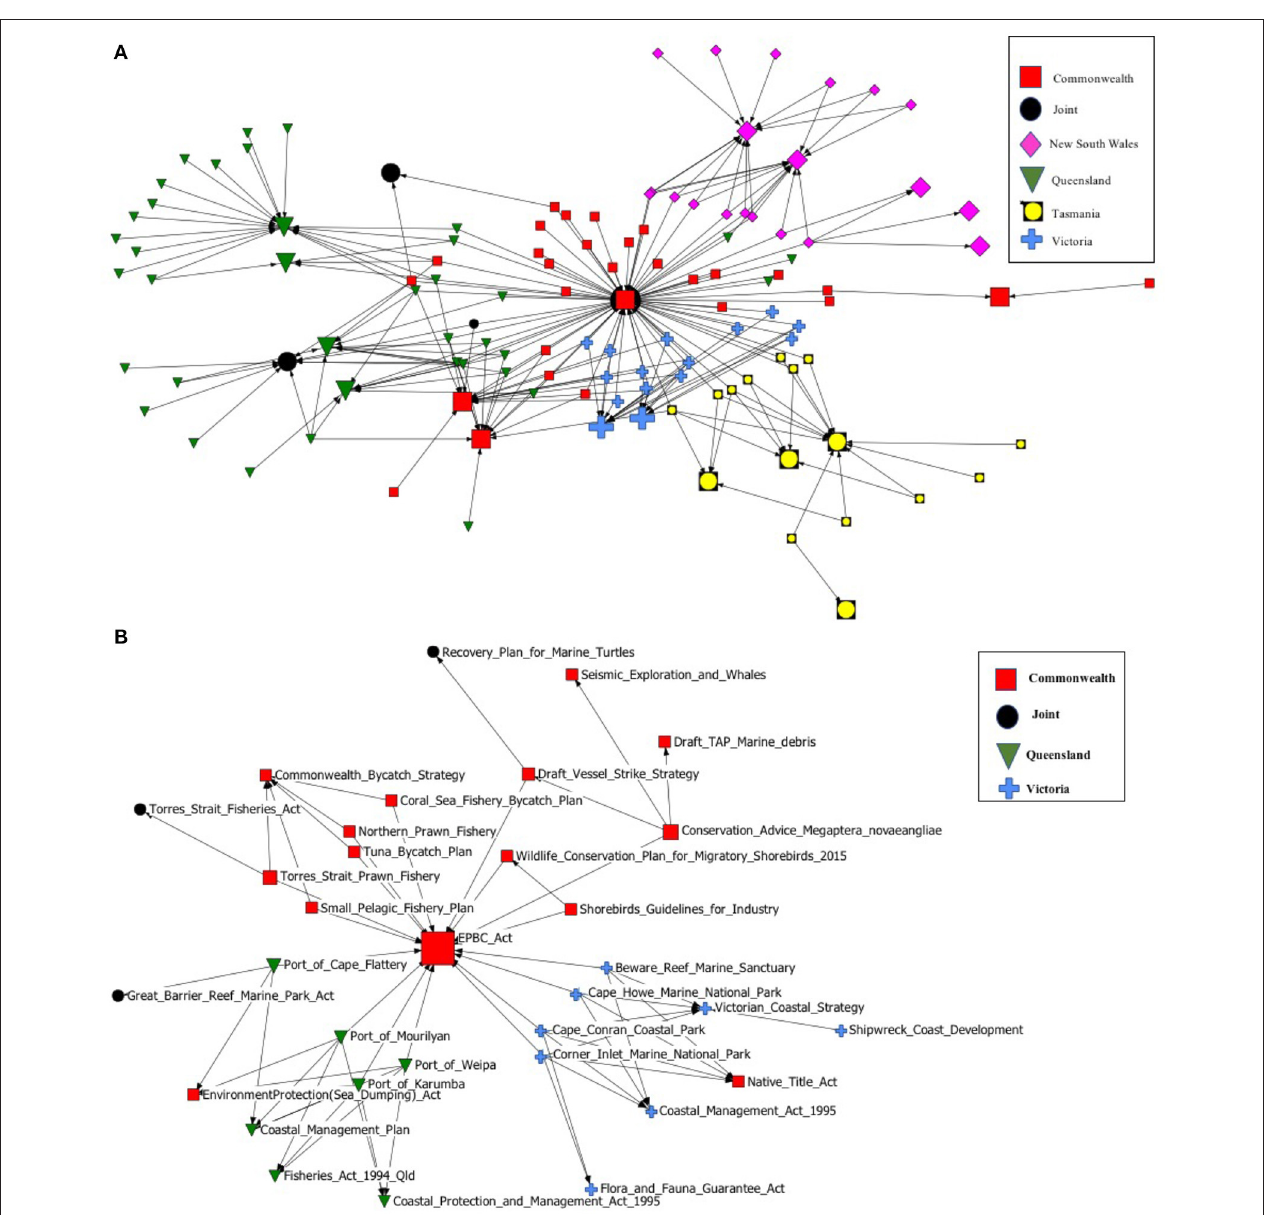
FIGURE 4 | (A) The relationship between reviewed environmental policies and management plans in Australia and (B) The relationship between reviewed plans in Australia, with environmental policies included to show indirect connections. In both figures, symbols represent location. Node size is based on betweenness and node position is based on centrality within the network. The betweenness of policies and management plans (A) and management plans (B) in relation with other policies and management plans in Australia identifies the focal role of the EPBC Act 1999. Relationships are directional—the arrow points from one policy to another where a relationship has been